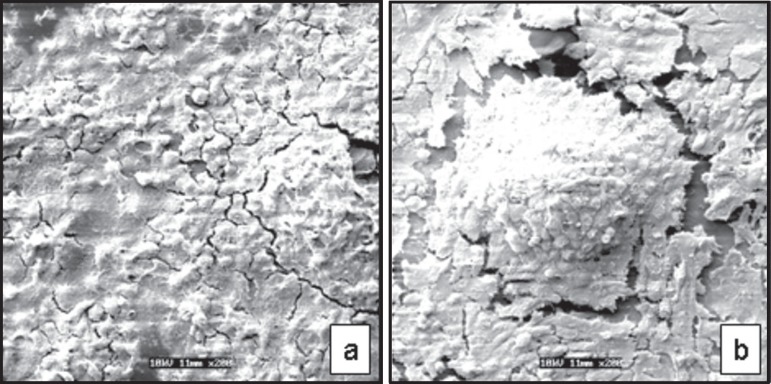
Negative control (α-MEM). Scanning Electron Microscopy original
magnification ×200. (a): MDPC-23 cells adhered to the glass substrate.
near confluence. (b): Cells organized as epithelioid nodules